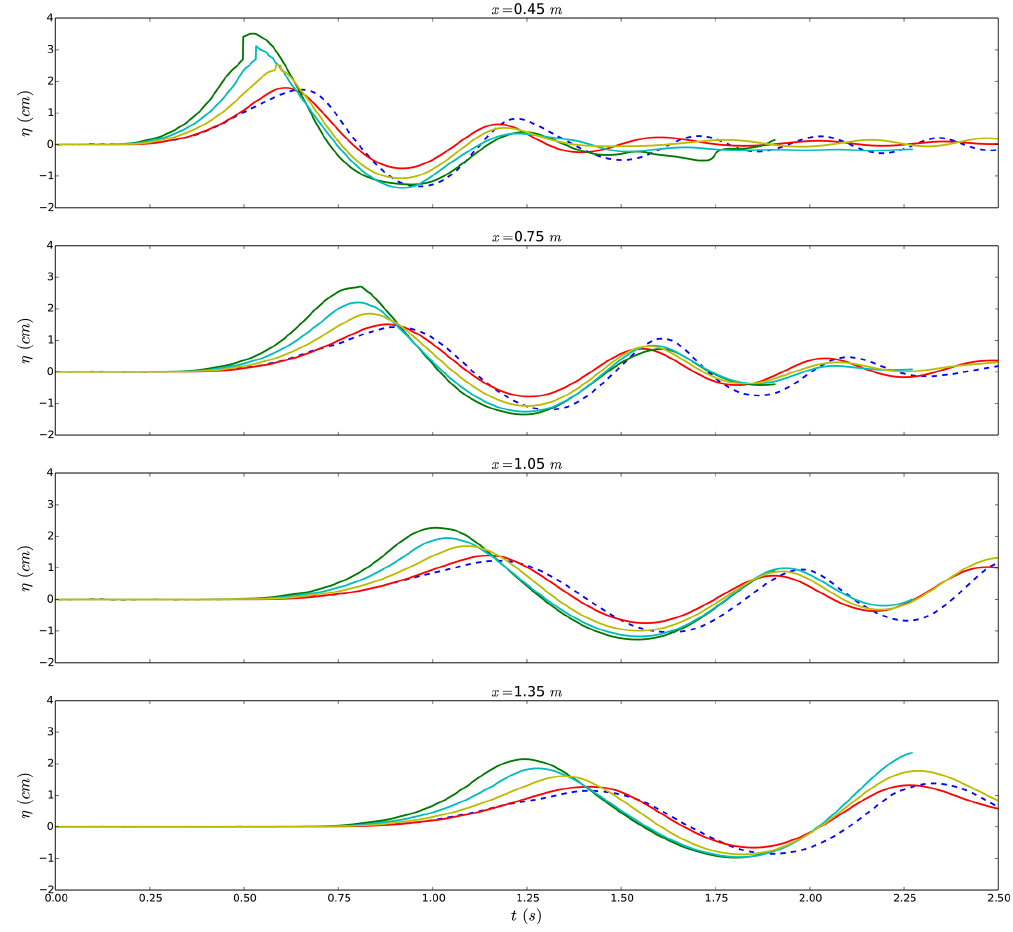
Figure 3. Free-surface elevation at the gauges for the experiment (blue dashed line) and the simulations of the first case presented in Viroulet et al. (2013) for different values of viscosity: µ = 1Pas: green line; µ = 2Pas: cyan line; µ = 5Pas: yellow line; and µ = 10Pas: red